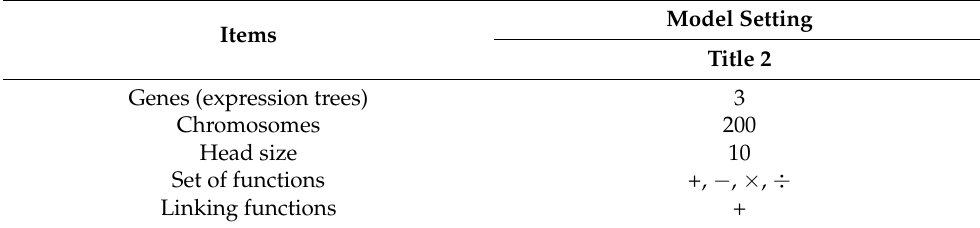
Model Setting Title 2